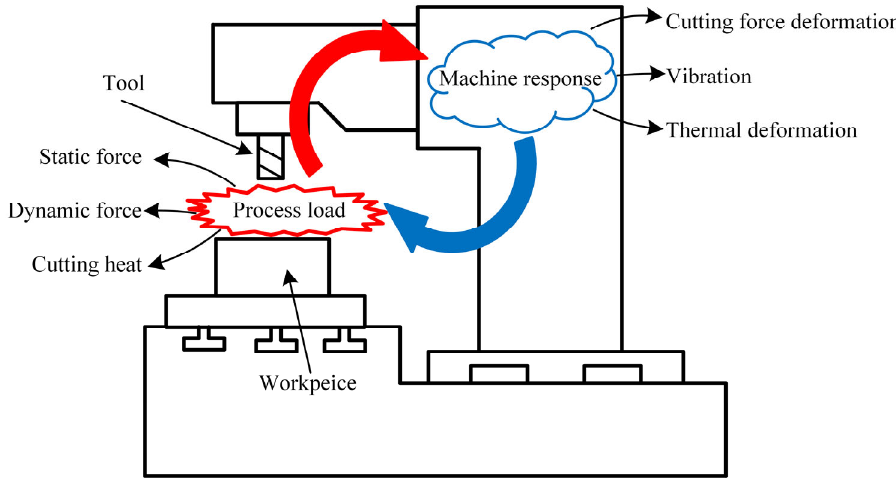
Figure 3. Principle of interaction between the machine tool and process.